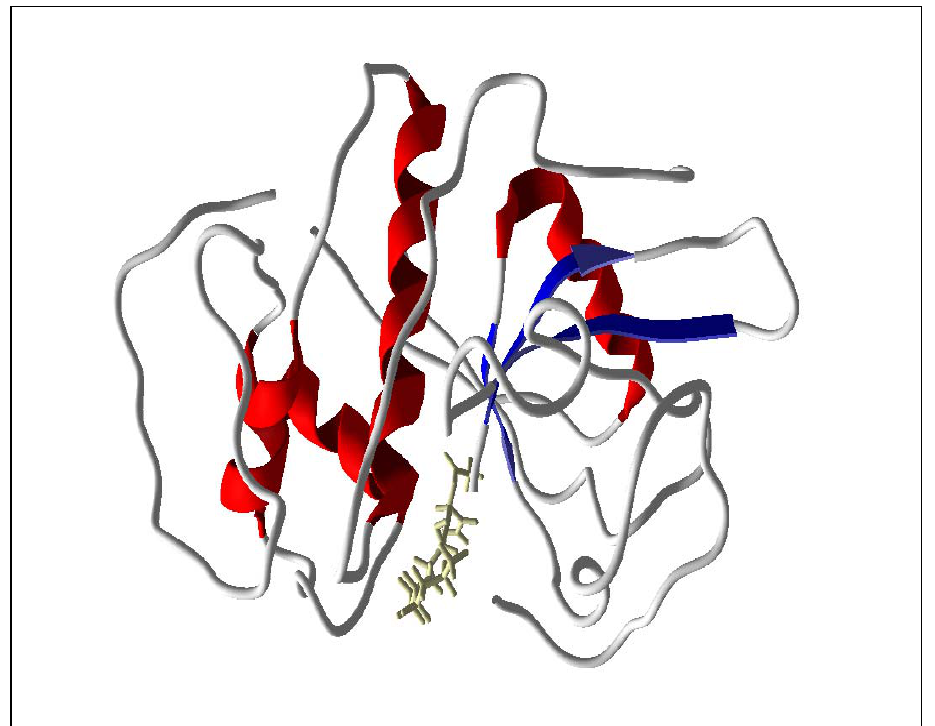
Supplementary Figure 2. Orientation of 8-hydroxylheptadeca-4, 6-diyn-3-yl acetate along the cleft of